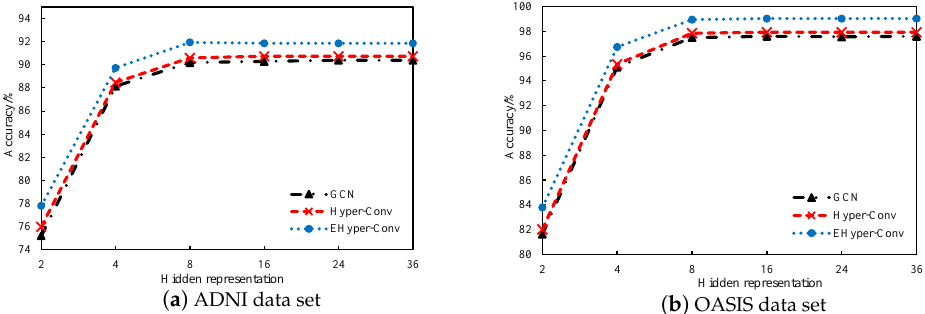
Figure 7. The effect of different hidden representations in two data